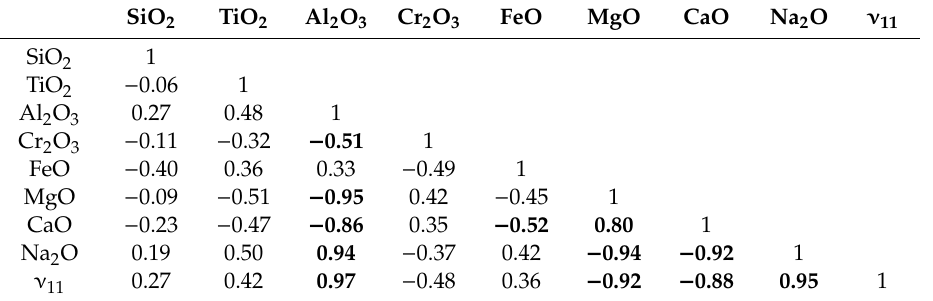
Table 1. The correlation coe ffi cients for linear dependences between major elements and stretching vibration mode ( ν 11 ) in clinopyroxenes (the bold are significant at α = 10 − 4